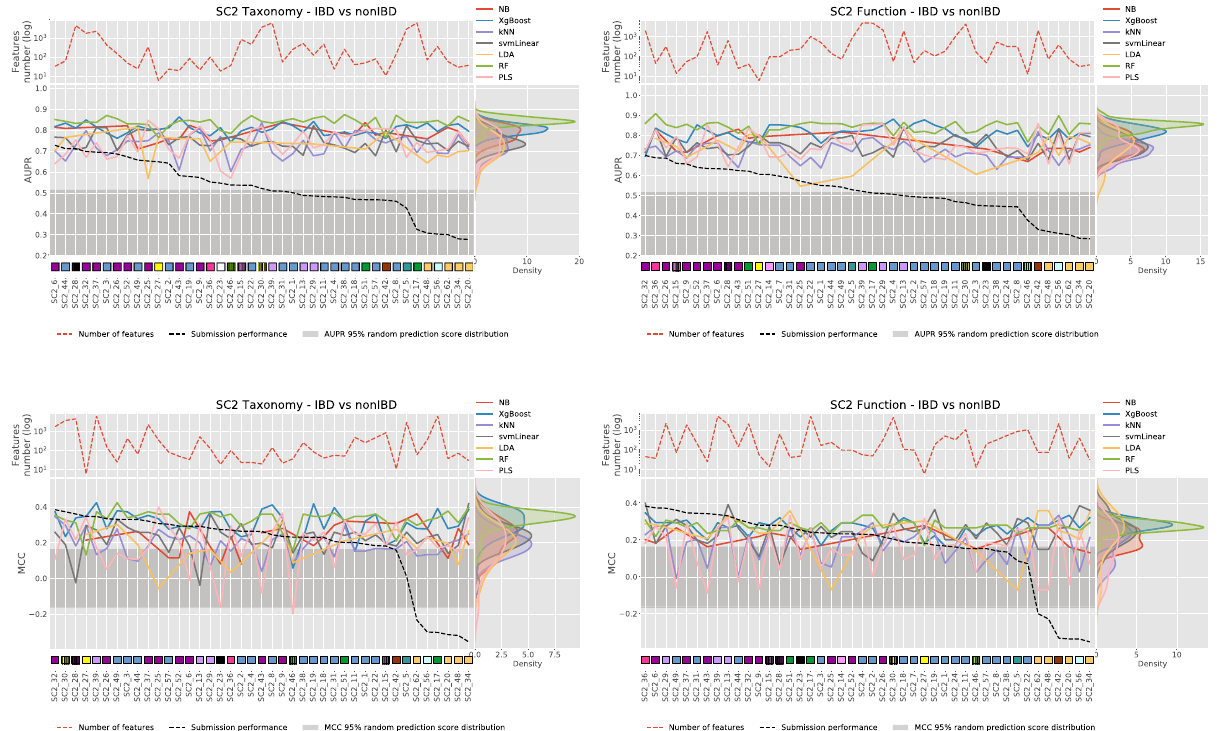
Figure 4. Robustness of individual SC2 “IBD versus nonIBD” signatures controlled using seven in-house ML methods. Results for each data type and metric are shown separately. Submissions are sorted from the best to the worst based on the challenge performance for the relevant data type. Individual performances are shown with dashed black line, performances of each of the seven in-house ML methods are shown with colored lines. The classification algorithm used in each individual submission is shown using the square symbol, the legend can be found on the Fig. 2. The top panel for each graphics represents the number of features per signature in a log10 scale. Finally, the right panel represents the distribution of scores obtained when using individual signatures per ML method.